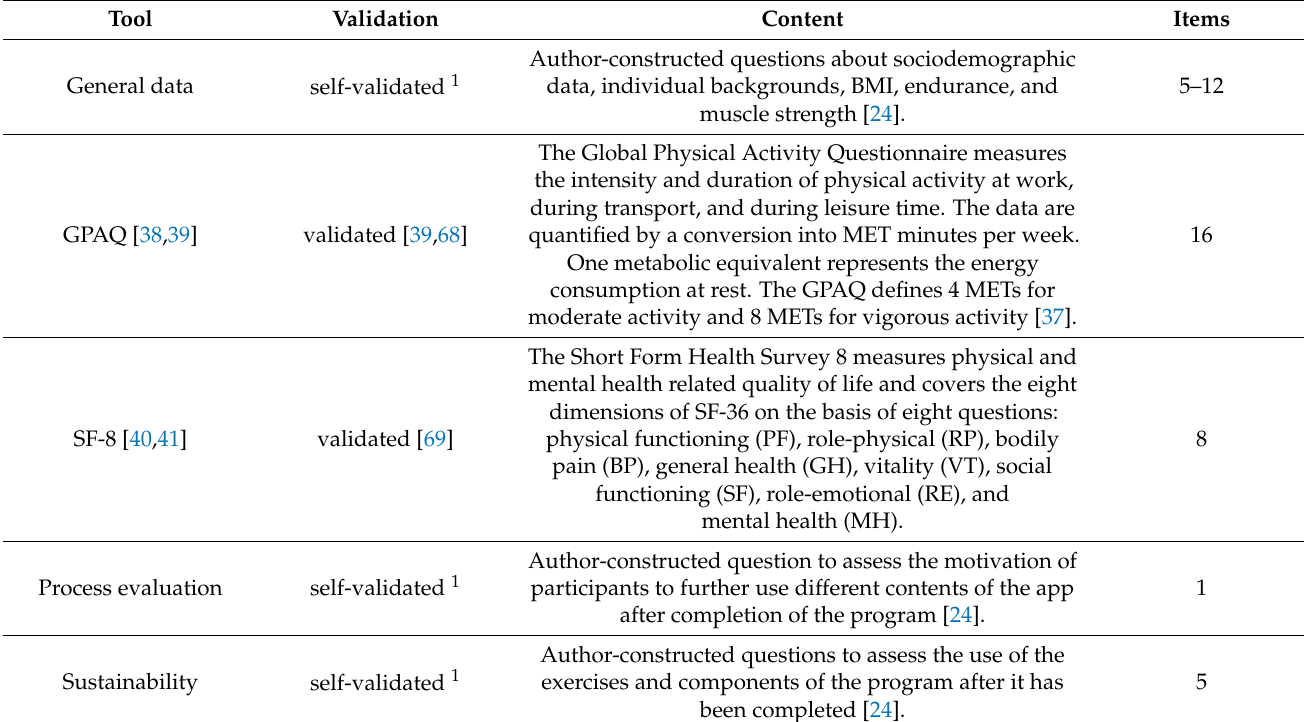
Table A1. Summary of the measurements used in this follow-up study, based on the study-protocol [24]. Tool General